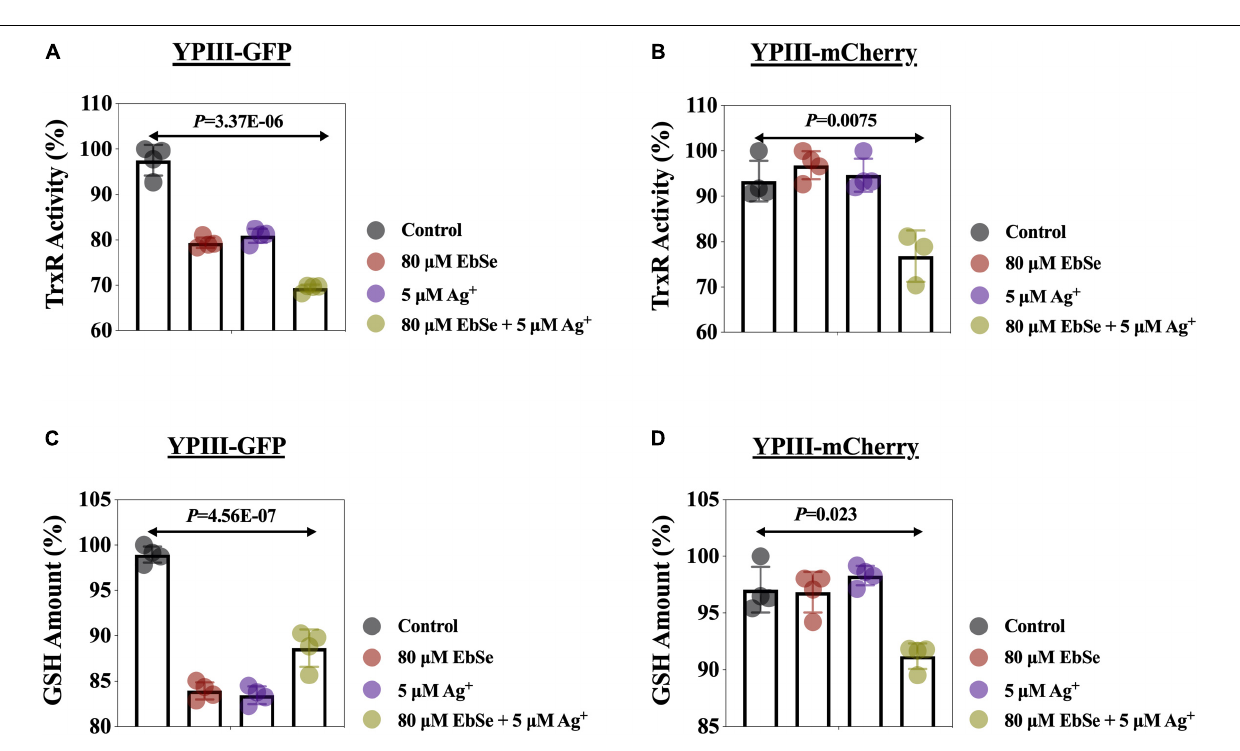
Frontiers in Microbiology |